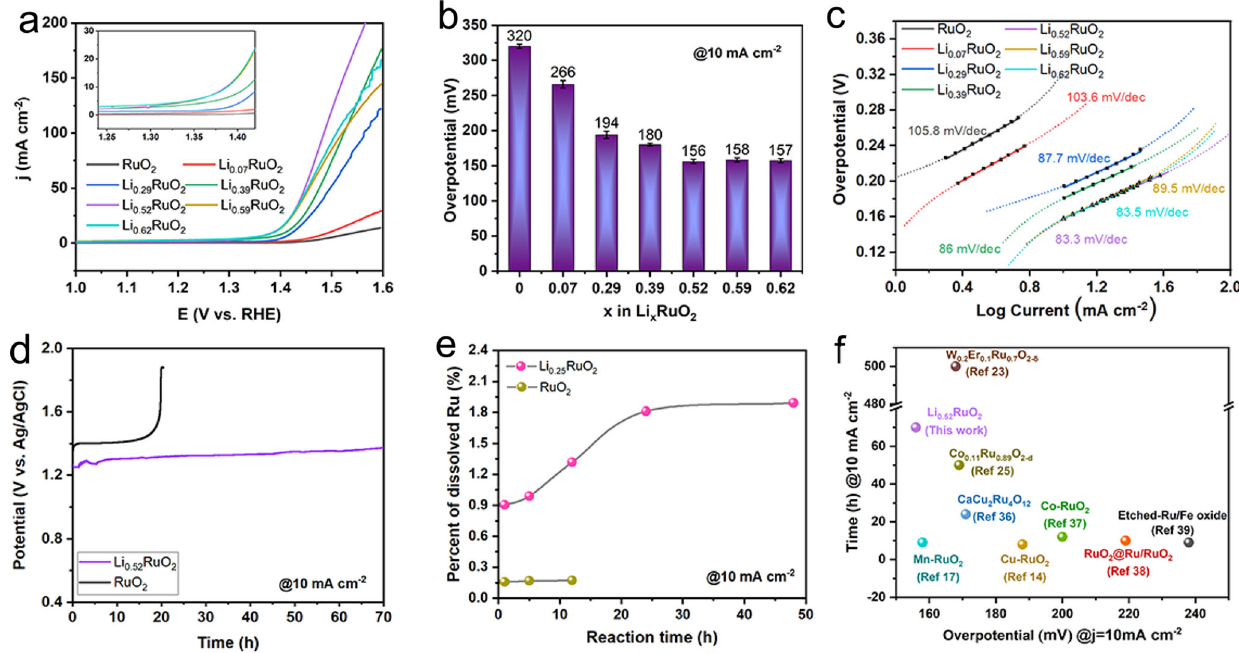
Fig. 2 OER performance in 0.5 M H 2 SO 4 solution. a Polarization curves. RHE reversible hydrogen electrode. b Overpotentials ( η 10 ) of RuO 2 and Li x RuO 2 at 10 mA cm − 2 . The error bars represent the deviation from the overpotentials in ( a ). c Tafel plots. d Chronopotentiometry curve of Li 0.52 RuO 2 and RuO 2 at a current density of 10 mA cm − 2 . e Percentage of Ru dissolved from RuO 2 and Li 0.52 RuO 2 after electrocatalysis for different reaction times. f Comparison of the overpotential required to achieve a 10 mA cm − 2 cathodic current density and chronopotentiometry durability at 10 mA cm − 2 in acidic media for various RuO 2 -based electrocatalysts 14,17,23,25,40 – 43